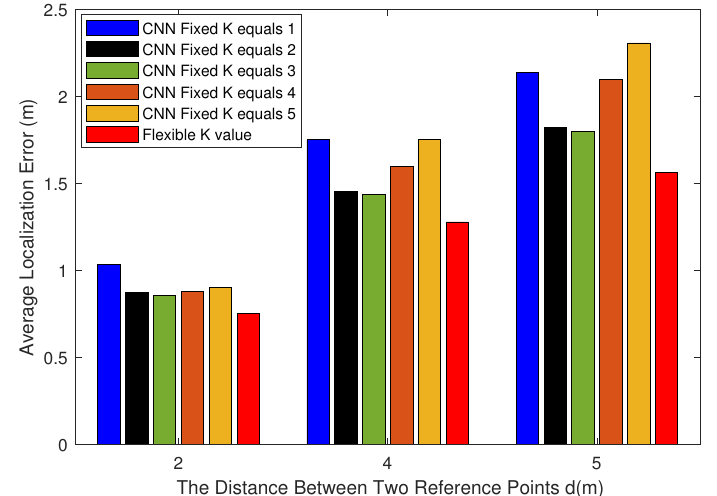
Figure 10. The average localization error for different reference point